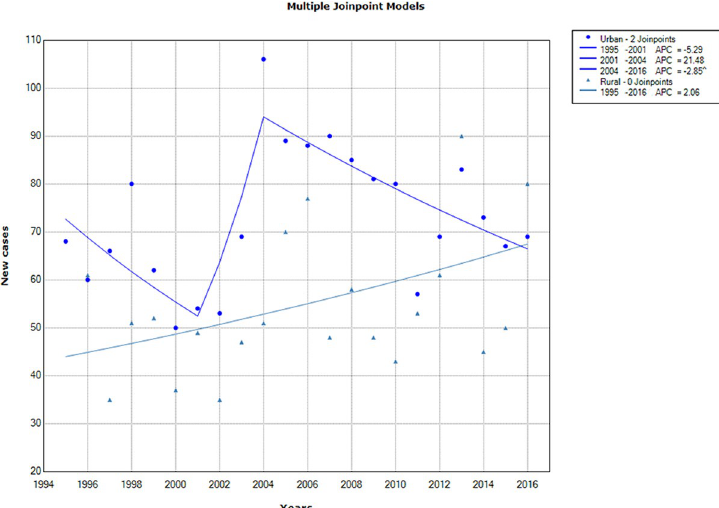
Fig 4. Chronological trends analysis of tuberculosis annual number in urban and rural districts between 1995 and